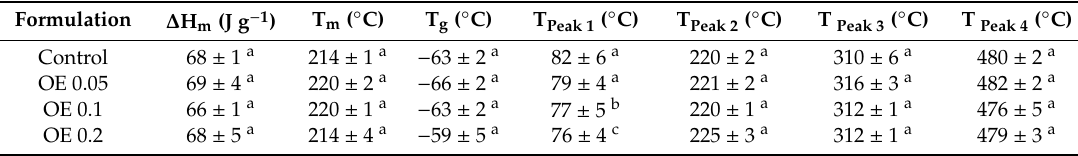
Table 2. Thermal parameters obtained by DSC and thermogravimetric analysis (TGA) for edible films. Mean ± SD ( n =